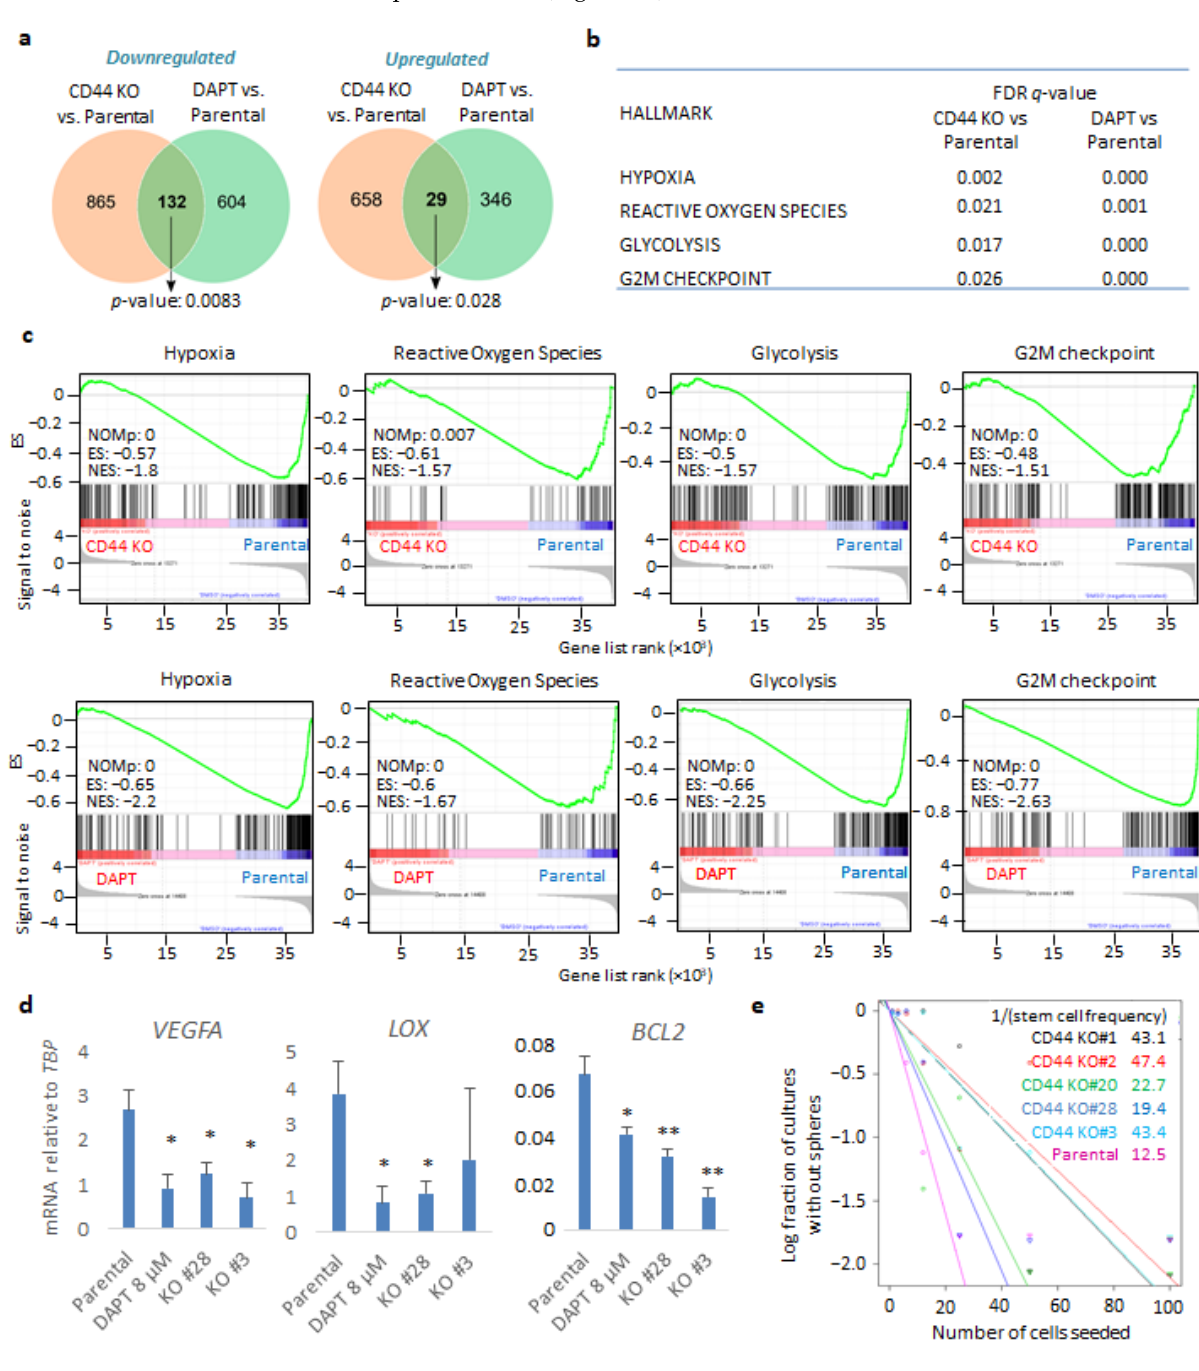
Figure 2. CD44 genetic depletion and inhibition of CD44 cleavage leads to common gene signatures in U251MG cells grown in sphere-like conditions. ( a ) Venn diagram of overlapping down- or up- regulated genes comparing parental U251MG cells to either CD44 KO cells or U251MG cells treated with the γ -secretase inhibitor DAPT; p - values are computed using Fisher’s Exact test. Cells were grown in low-attachment conditions. ( b ) FDR q -values of specific gene signatures (hallmarks) upon CD44 KO or treatment of parental U251MG with DAPT, compared to control cells. ( c ) Specific gene set enrichment analyses of the transcriptome between parental U251MG cells and CD44 KO cells, or parental U251MG cells treated with DAPT. ES, enrichment score; NES, normalized ES; NOMp, nominal p -value. ( d ) Hypoxia-related genes VEGFA, LOX, and BCL2 mRNAs were quantified in the respective conditions by RT-PCR and demonstrated after normalization to TBP. Asterisks show